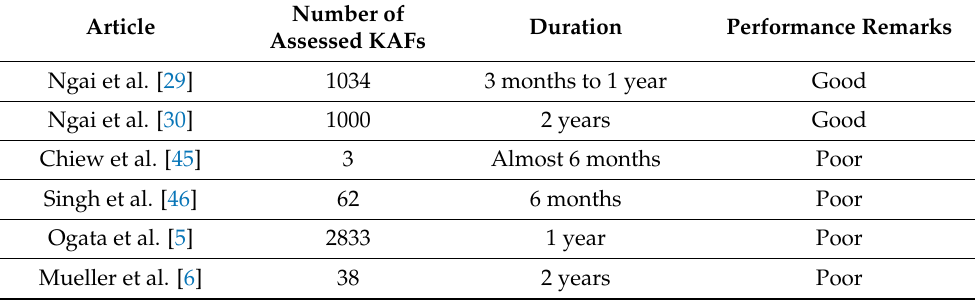
Table 1. An overview of assessment studies and conclusions regarding the performance of